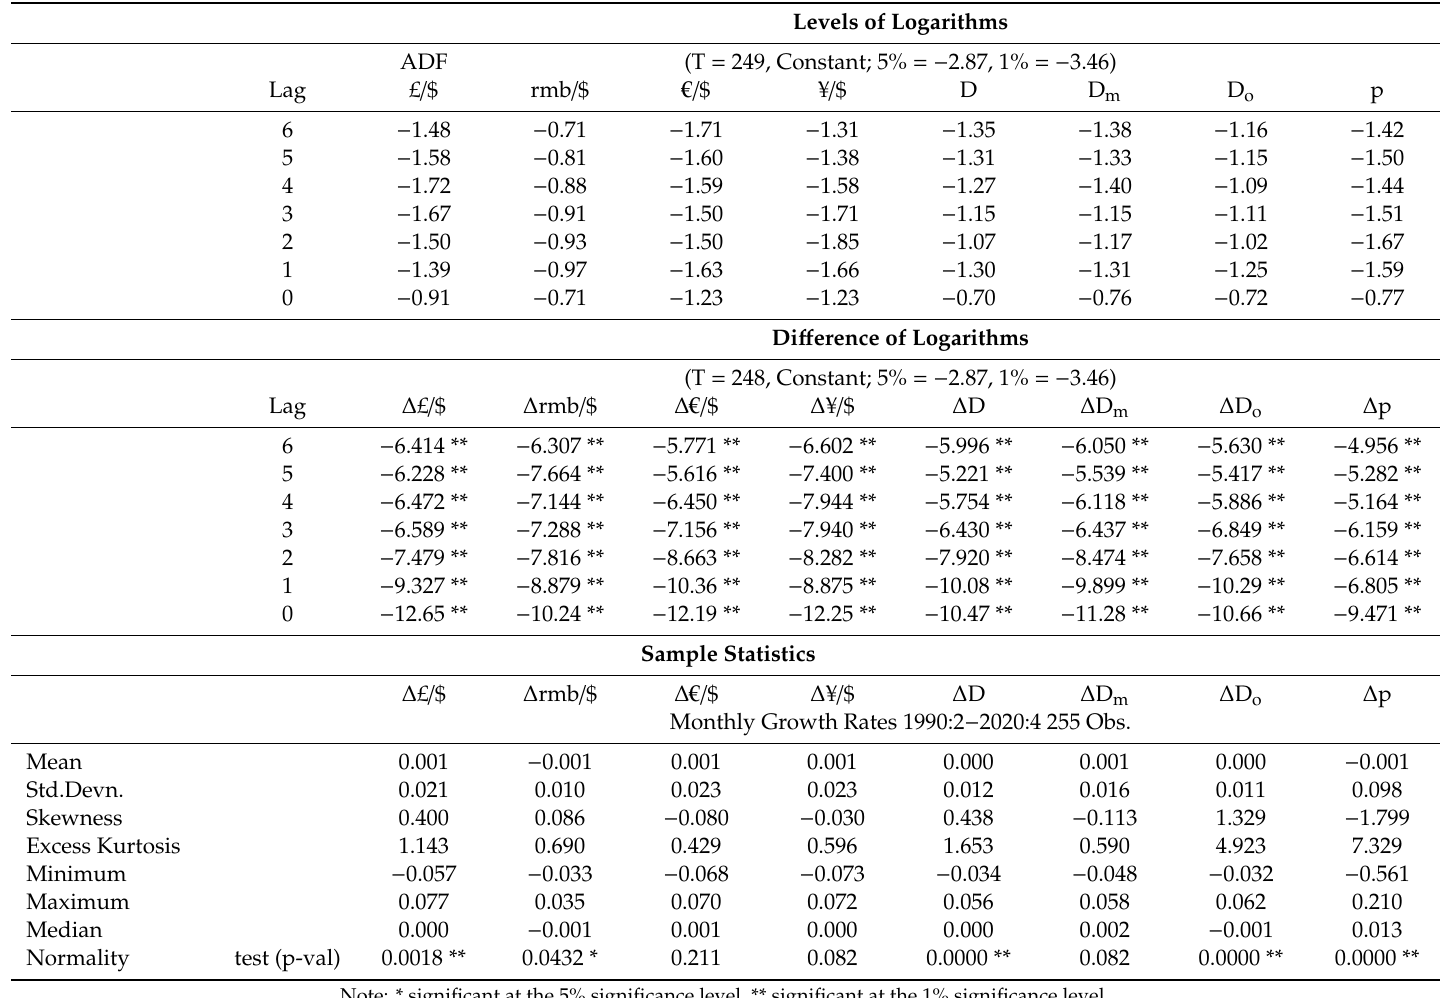
Table A1. Augmented Dickey Fuller